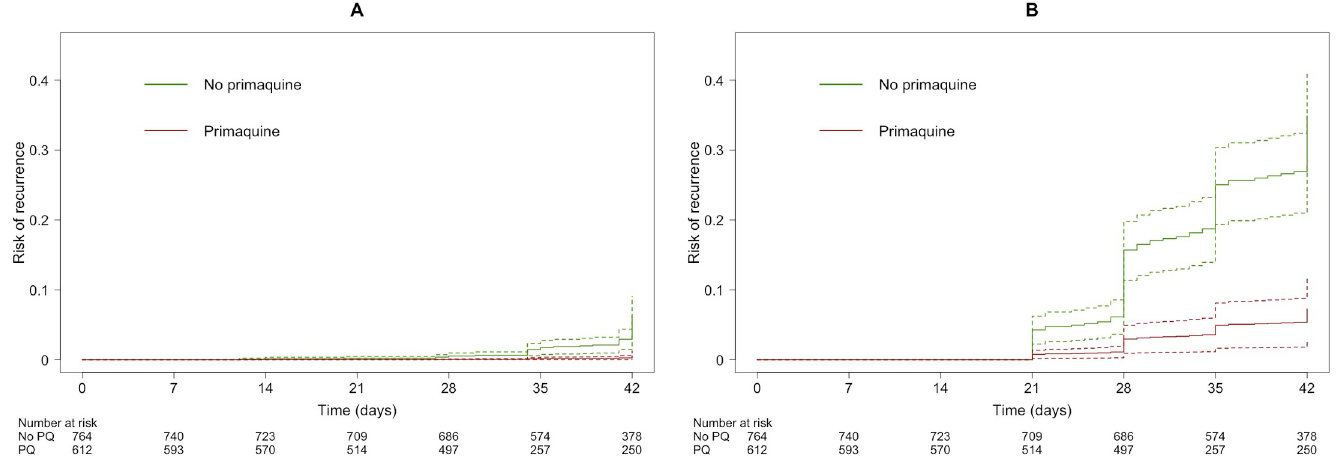
Fig 3. Risk of recurrence (solid line, estimate; dashed lines, limits of 95% CI) adjusted for age, mg/kg piperaquine or lumefantrine dose, gender, relapse periodicity, baseline haemoglobin, and baseline parasitaemia comparing treatment with and without PQ in patients receiving (A) dihydroartemisinin- piperaquine ( p = 0.0933) or (B) artemether-lumefantrine ( p < 0.001). Assumes zero effect from study site; p -values derived from Cox model. CI, confidence interval; PQ, primaquine.